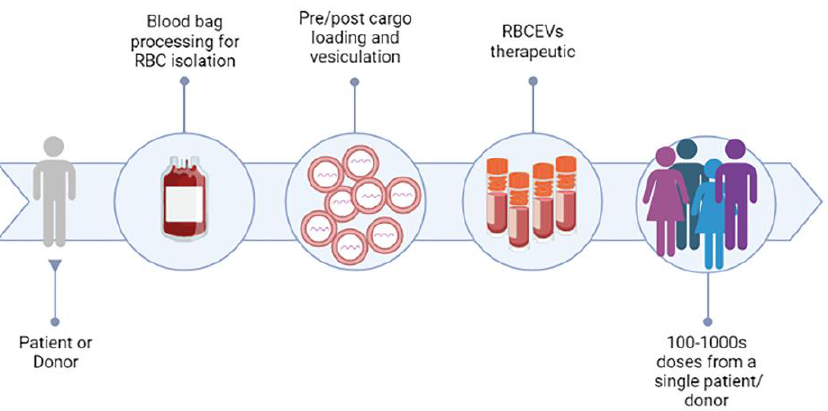
Figure 6. RBCEVs platform for clinical exploitation. The figure represents the road for the clinical exploitation of RBC-derived EVs, which could be achieved in the near future, and shows some of the advantages of this promising strategy. Created in Biorender.com, accessed on 14 December 2022.